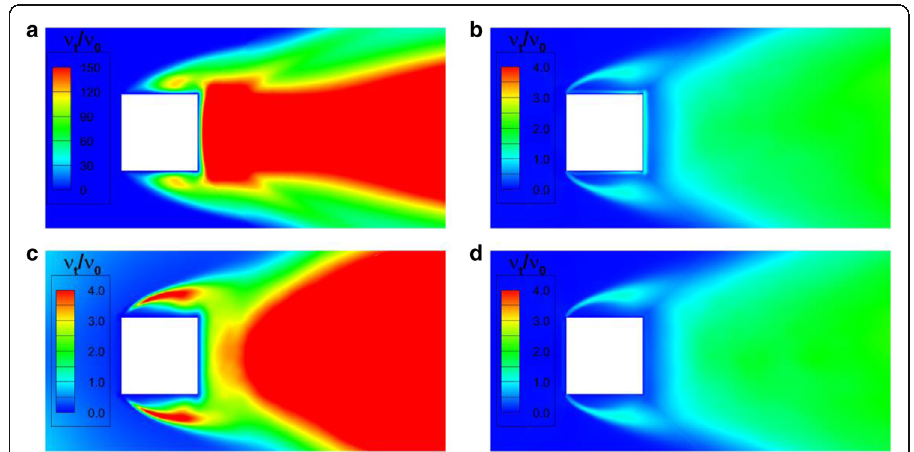
Fig. 10 Time-averaged eddy viscosity contours based on a 2D simulation by URANS model on 2D mesh; b 3D simulation by Gieseking model on Mesh-B; c 3D simulation by the original IDDES model on Mesh-B; d 3D simulation by the modified IDDES model on Mesh-B